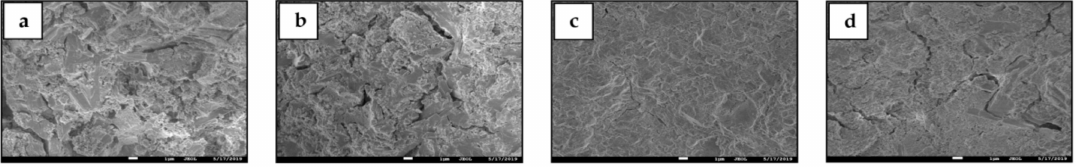
Figure 25. SEM micromorphology of GF-HBSAC-20% cement hydration products at di ff erent curing ages: ( a ) One day; ( b ) 3 days; ( c ) 7 days; ( d ) 28